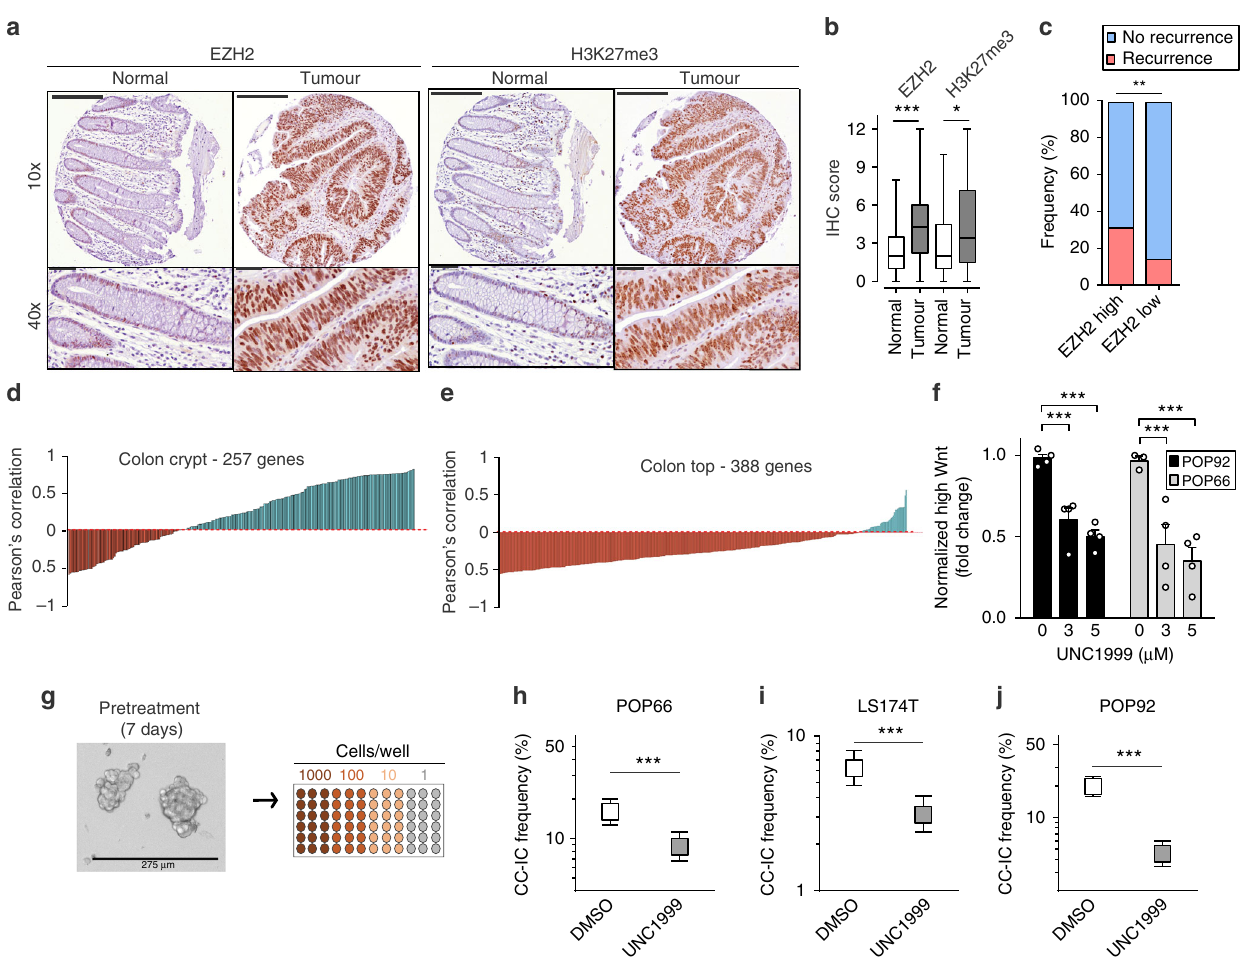
Fig. 2 Inhibition of EZH2 reduces CC-IC frequency in vitro. a Tissue microarray samples processed for immunohistochemistry staining of EZH2 and H3K27me3. Pictures shown are representative of 32 patients (normal) and 251 patients (tumour). Scale bars are 200 µ m (10 × ) and 50 µ m (40 × ). b Intensity of IHC staining performed in ( a ) was scored manually as described in the Methods section, and plotted as median± min and max, n = 32 (normal), n = 251 (tumour), Student ’ s t test. c Frequency of disease recurrence in patients within the top and bottom quintiles of EZH2 IHC expression as determined in ( a , b ) (EZH2-low IHC score < 2.4; EZH2-High IHC score > 9.6) (Chi-square test). d , e Pearson ’ s correlation value for EZH2 mRNA levels from TCGA CRC patient samples (COAD), compared with those of 257 genes from a colon crypt (stem cell) gene expression signature ( d ), and 388 genes from a colon top (differentiated) expression signature ( e ). Inverse correlations are plotted in red and positive correlations in blue. f TCF/LEF GFP Wnt reporter activity in POP92 and POP66 after 7 days of UNC1999 or UNC2400 treatment. Data are plotted normalised to DMSO control to the 10% brightest Wnt-High population ( n = 4, ± SEM, two-way ANOVA). g – j Limiting dilution assay performed in vitro on UNC1999-pretreated cells at 3 µ M for 7 days. Data shown are n = 4 (POP66, ( h )), n = 6 (LS174T, ( i )), n = 6 (POP92, ( j )). Data are shown as mean ± 95% con fi dence interval, frequency and probability were computed using ELDA software) * P < 0.05, ** P < 0.01, *** P < 0.001. Source data are provided as a Source Data fi